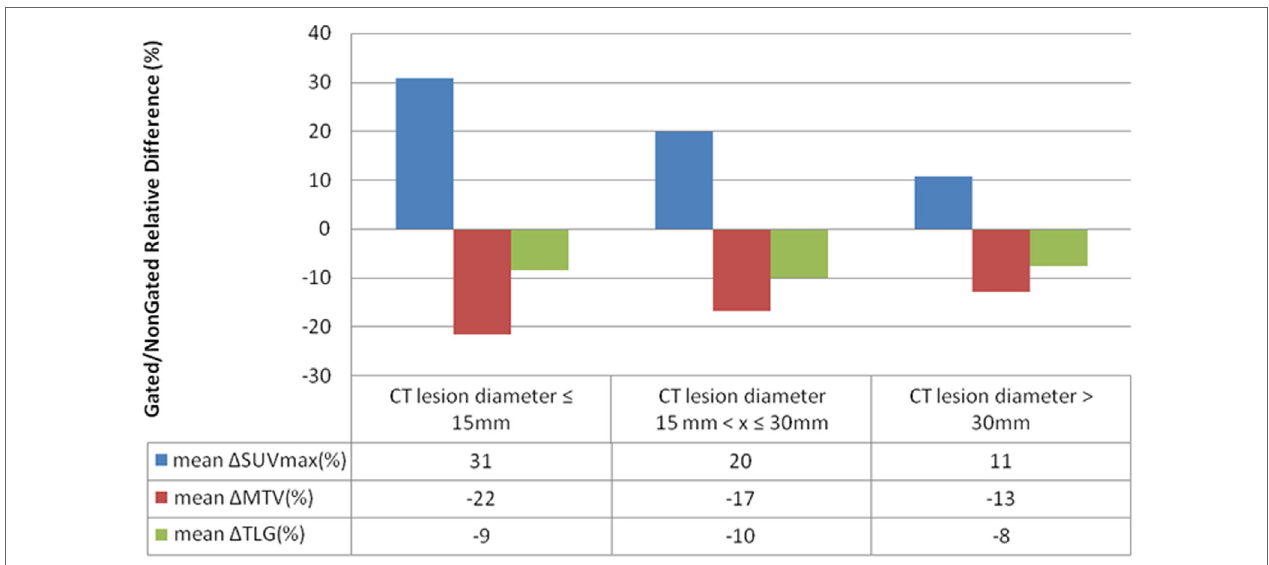
FigUre 5 | Mean SUVmax, metabolic tumor volume (MTV) and total lesion glycolysis (TLG) variations between respiratory-gated images and non-gated images according to lesions size for 119 measurables